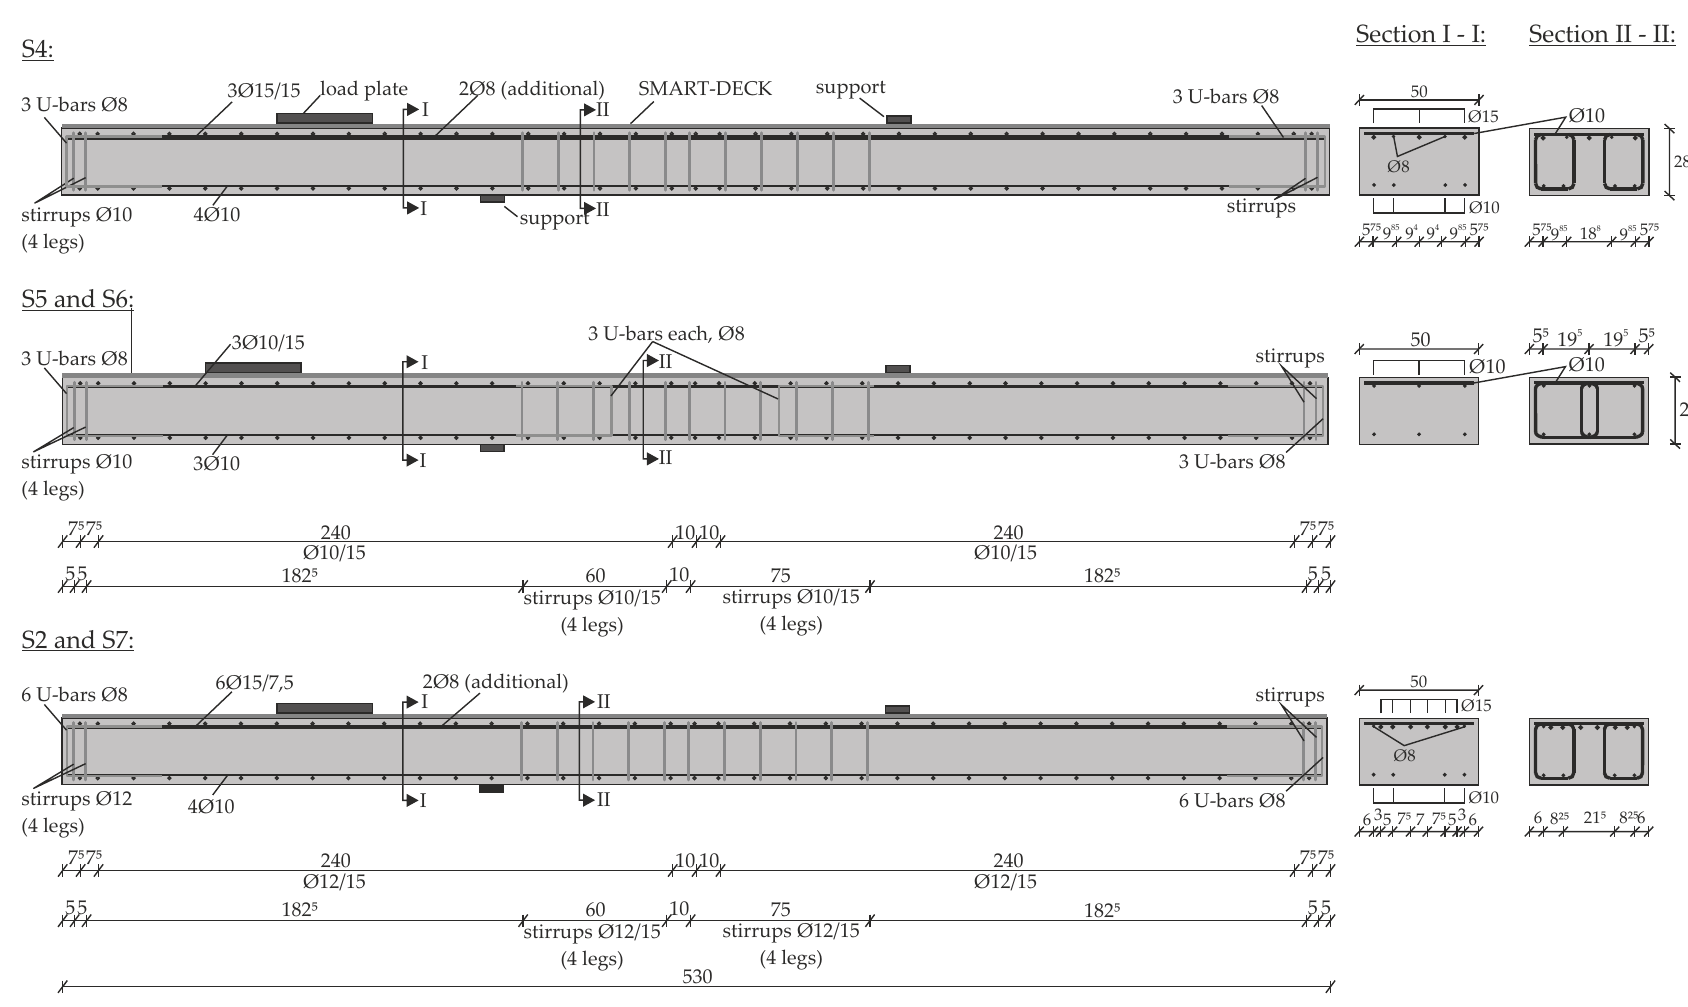
Figure 9. Outline of the reinforcement of the strengthened specimens S2, S4, S5, S6 and